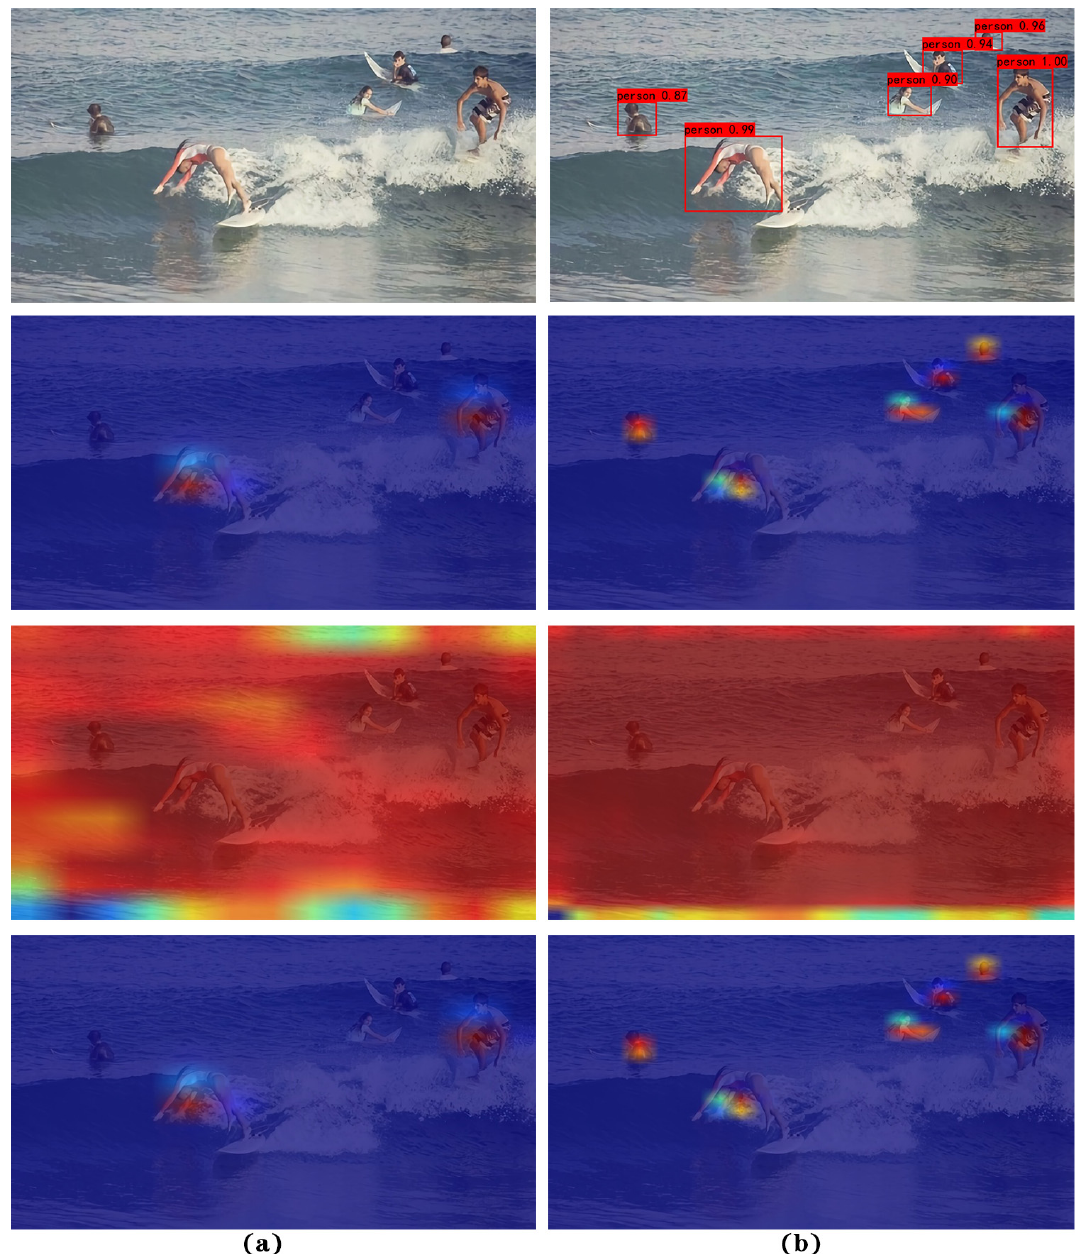
Figure 8. The feature visualization of the SRC-YOLO model. ( a ) The feature visualization of 13 × 13 size feature layer in YOLO head module; ( b ) the feature visualization of 26 × 26 size feature layer in the YOLO head